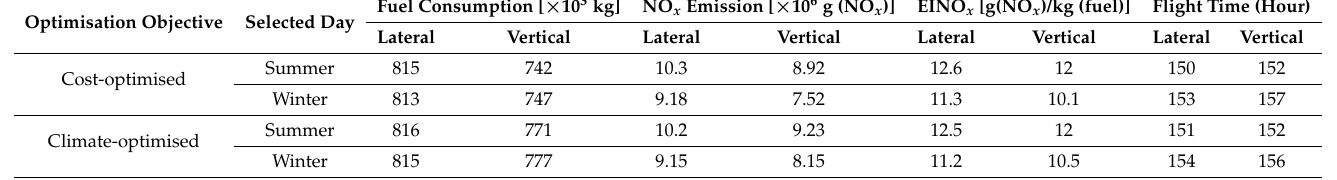
Table 5. Fuel consumption, NO x emissions, mean EINO x and total flight time from laterally and vertically re-routed flights.